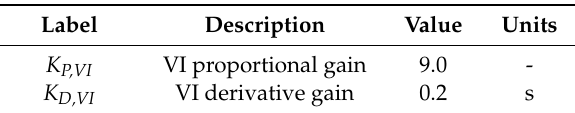
Table 4. Summary of VI